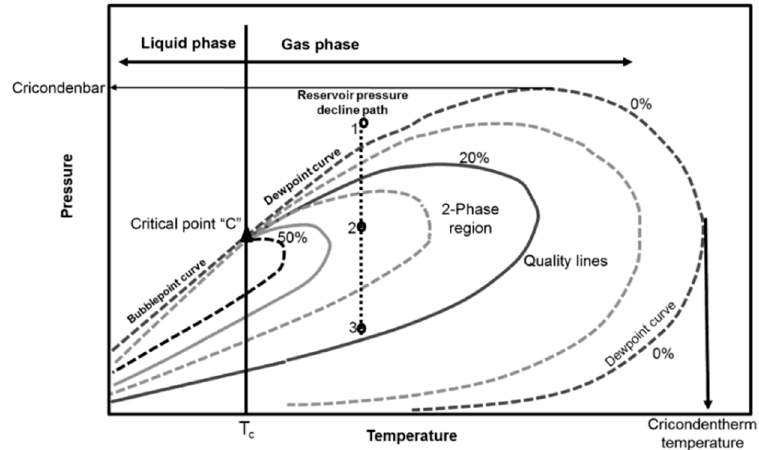
Figure 1. Typical temperature–pressure diagram for a multiphase system. Reproduced with persimission from [11], Copyright © 2010